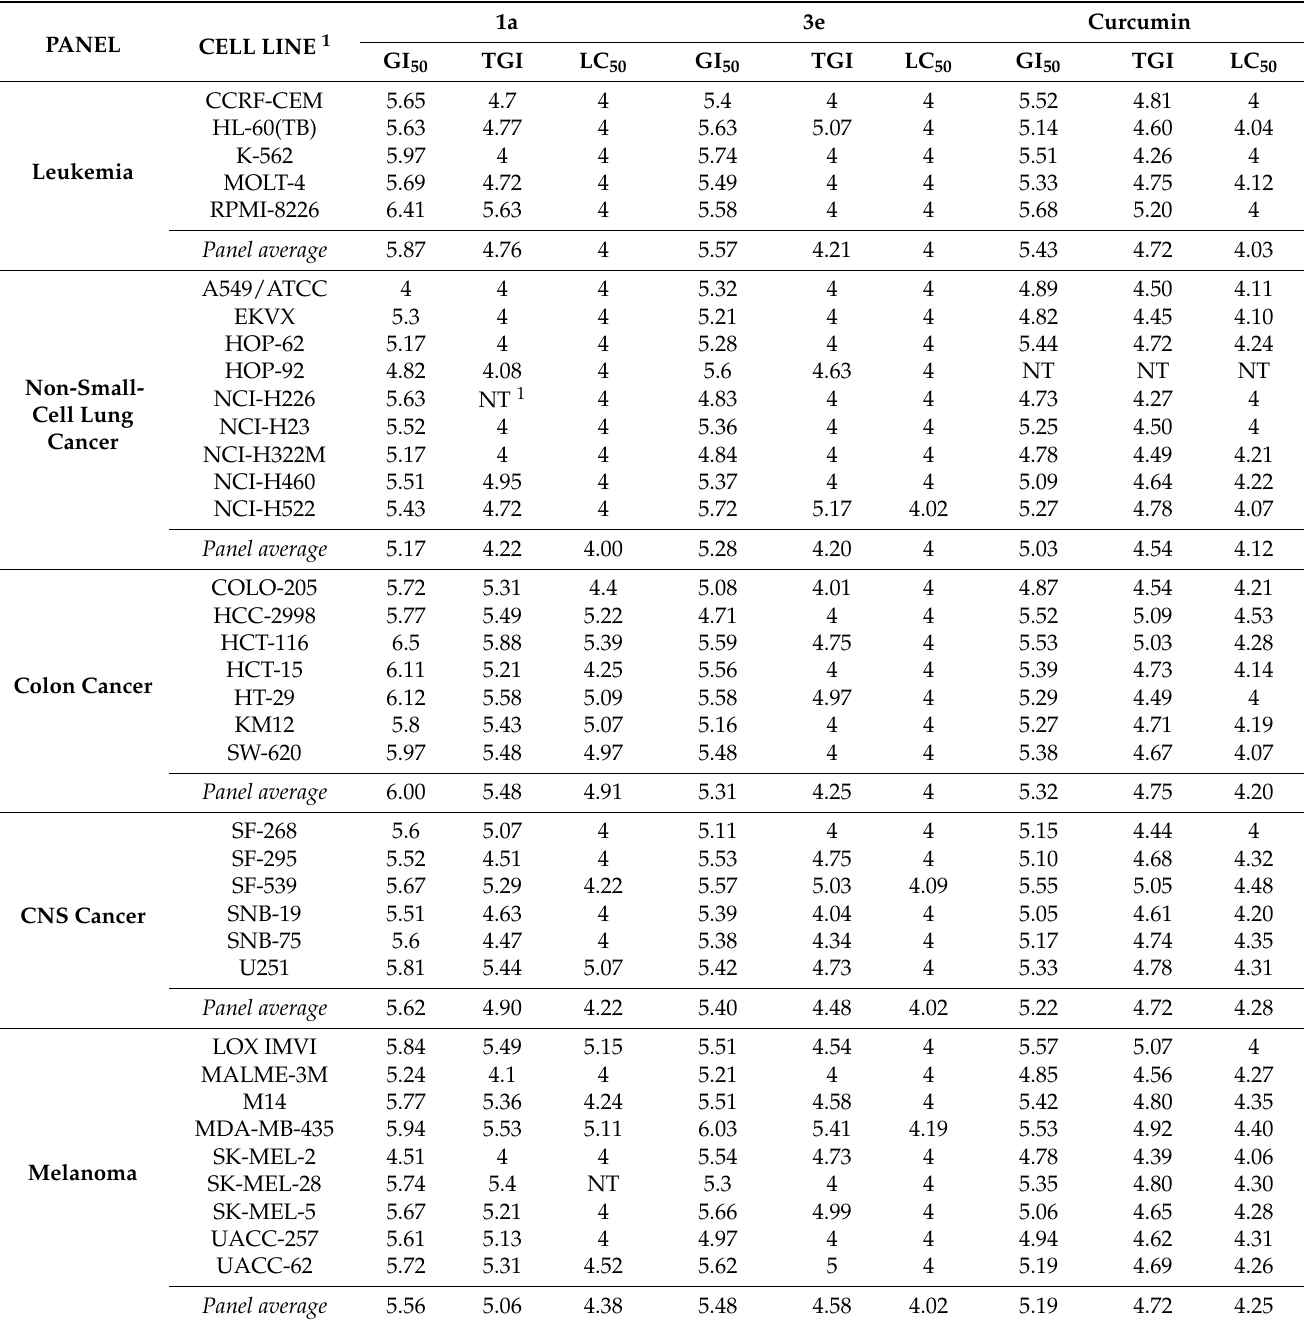
Table 5. DTP NCI five-dose screening for compounds 1a , 3e, and curcumin